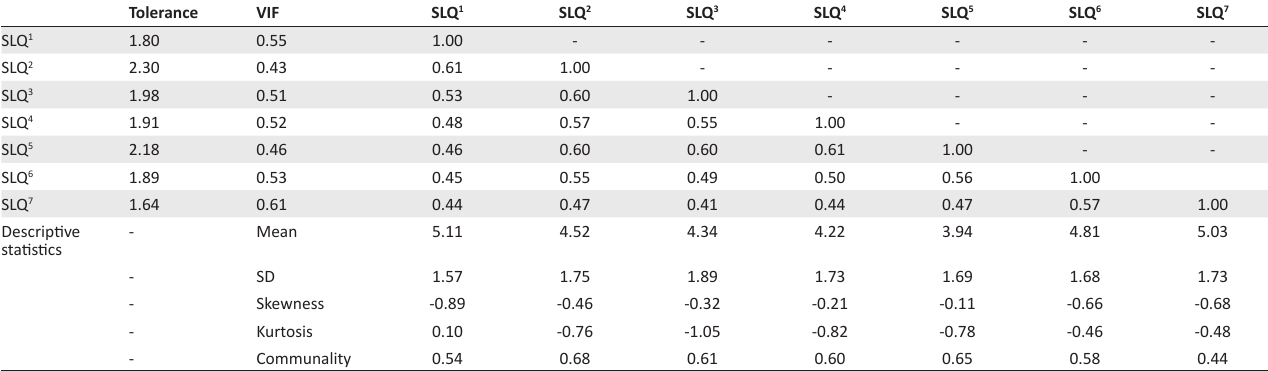
SLQ, servant leadership questionnaire; VIF, variance inflation factor; SD, standard deviation.